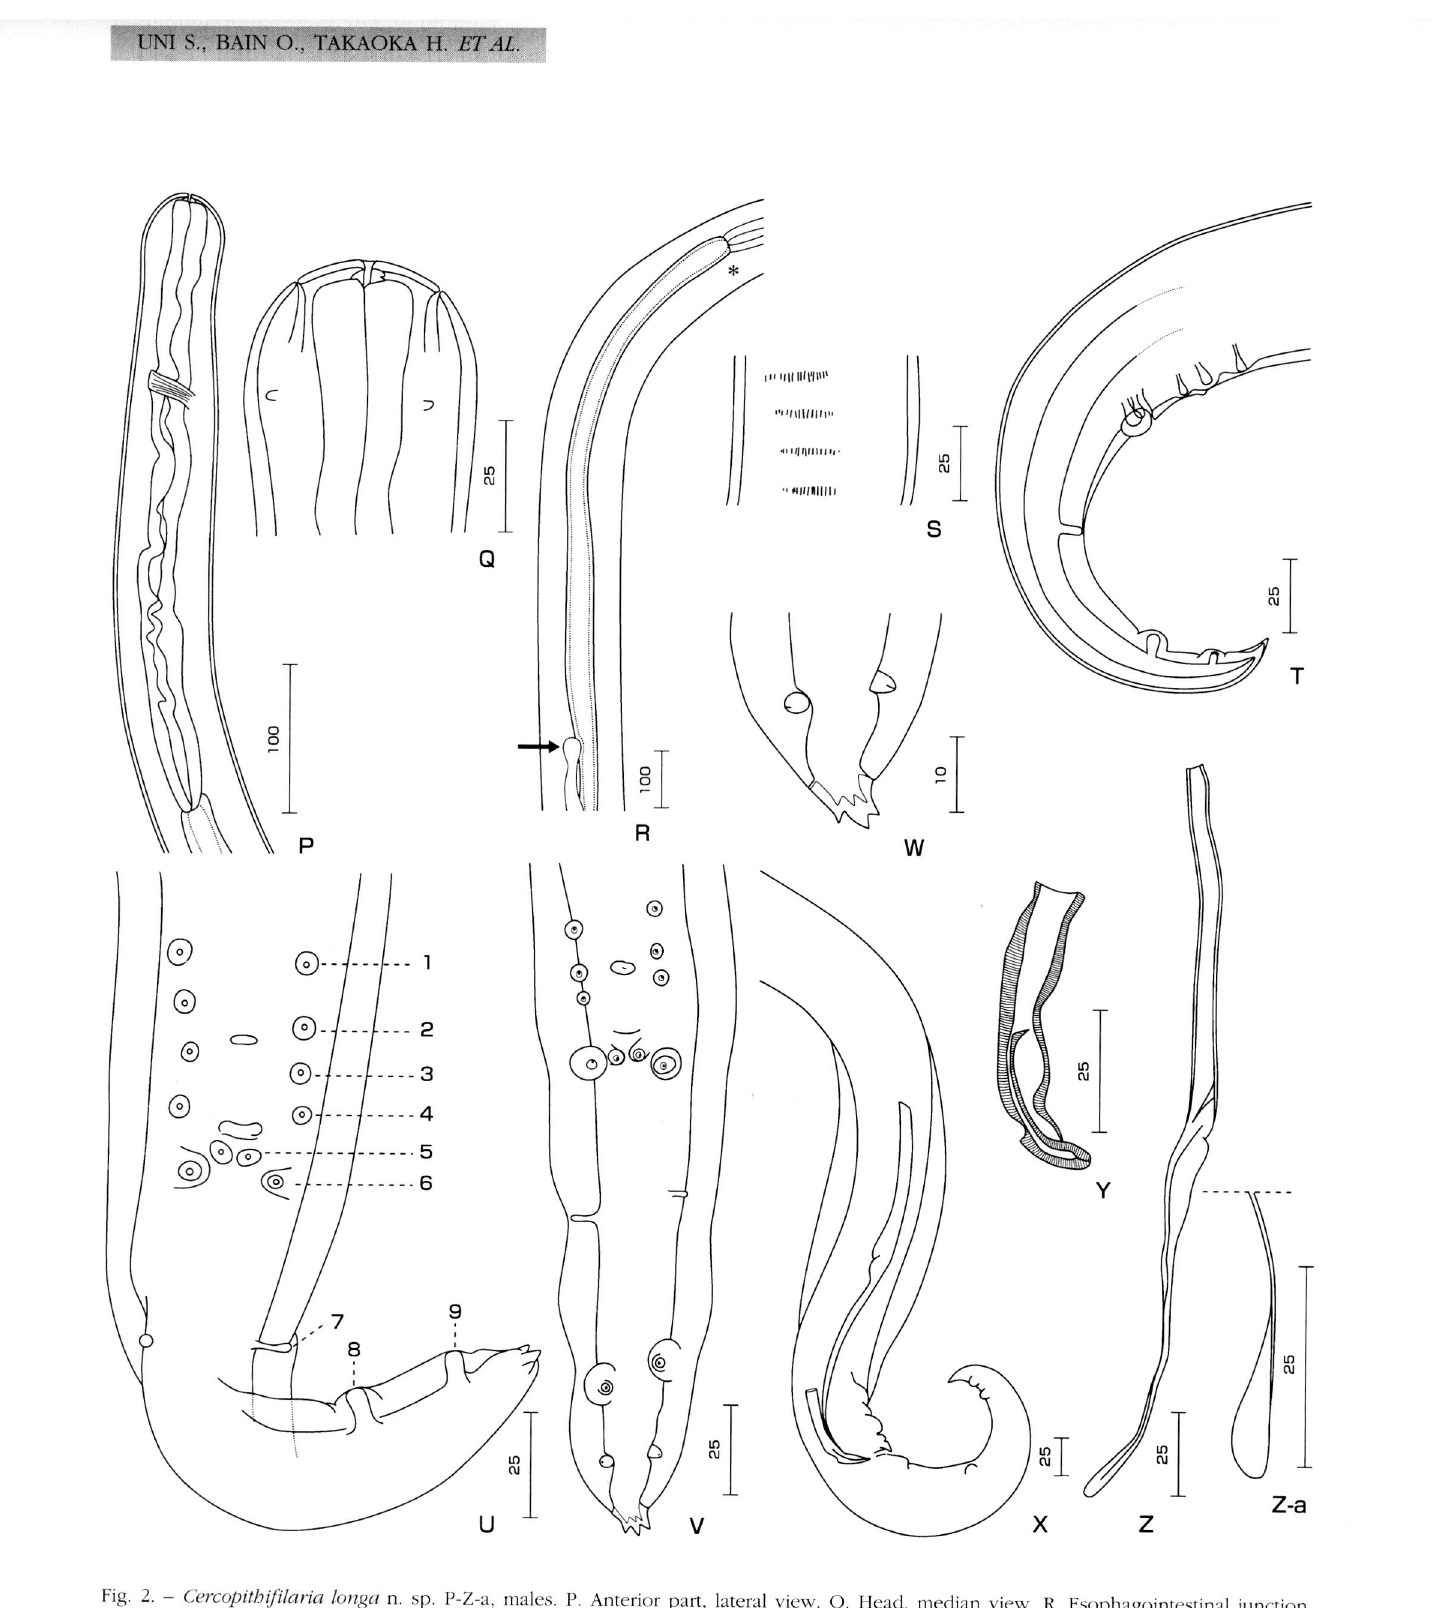
296 Parasite, 2002, 9,